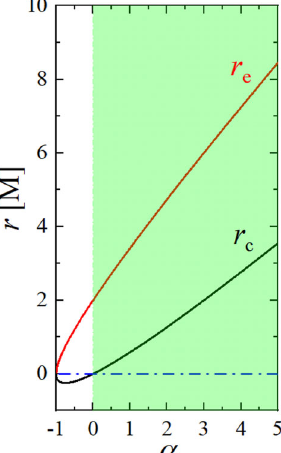
Fig. 1 The variation of radii of event horizon r e and Cauchy horizon r c with respect to the parameter α . The green region satisfies α > 0, where both r e and r c are greater than 0